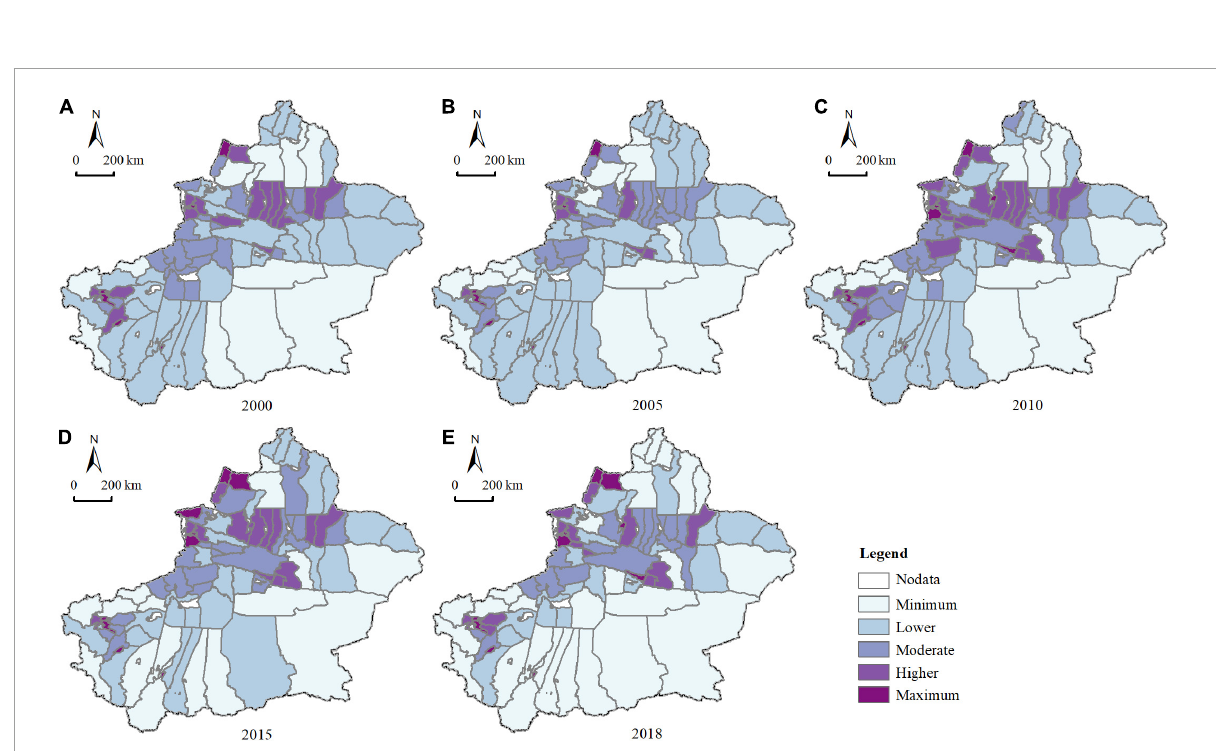
FIGURE5 Spatial distribution of farmland function pattern index in (A) 2000, (B) 2005, (C) 2010, (D) 2015, and (E) 2018.